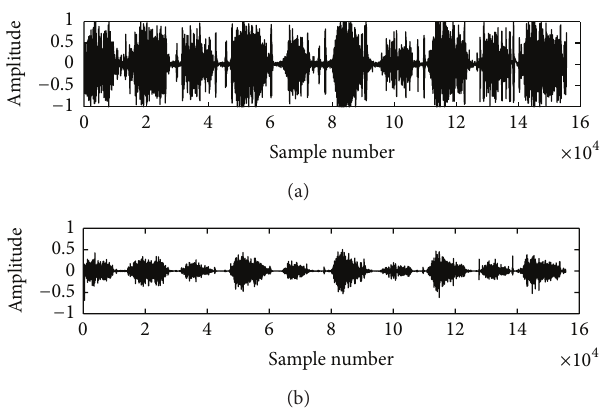
Figure 2: (a) It depicts the waveform of a noisy lung sound signal. (b) It shows the corresponding differentiation output of the nosy normal LS.